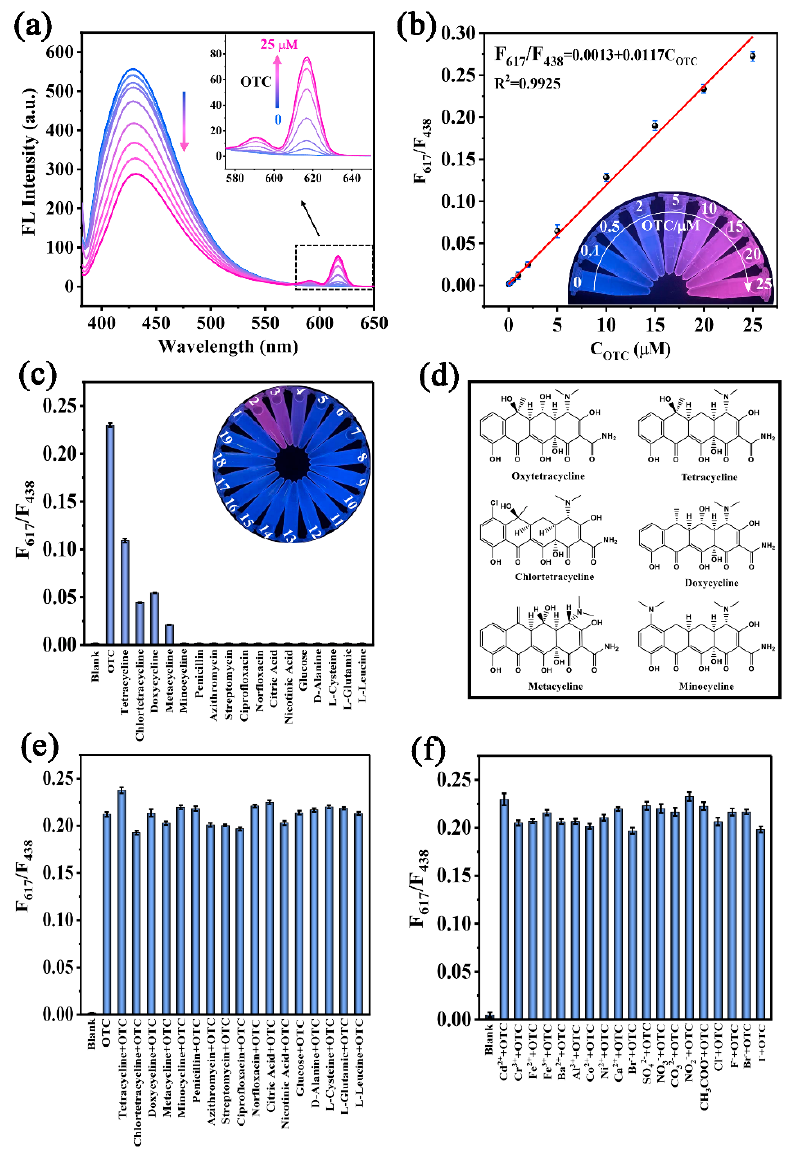
Figure 6. ( a ) Fluorescence response spectra of the NCDs/Eu 3+ probe towards to OTC. ( b ) Linear relationship of F 617 /F 438 vs. OTC concentration. Inset: the corresponding fluorescence images under a 365 nm UV lamp. ( c ) Selectivity (the inset is the corresponding fluorescence photos under the 365 nm UV lamp, 1–19 correspond to the abscissa name from left to right, respectively) of the probe for OTC assay. ( d ) Chemical structures of six TCs. ( e , f ) Anti-interference of the probe for OTC assay. The concentration of OTC and other antibiotics is 20 µM. The concentration of other interfering organic molecules, unions and cations is 50 µM.